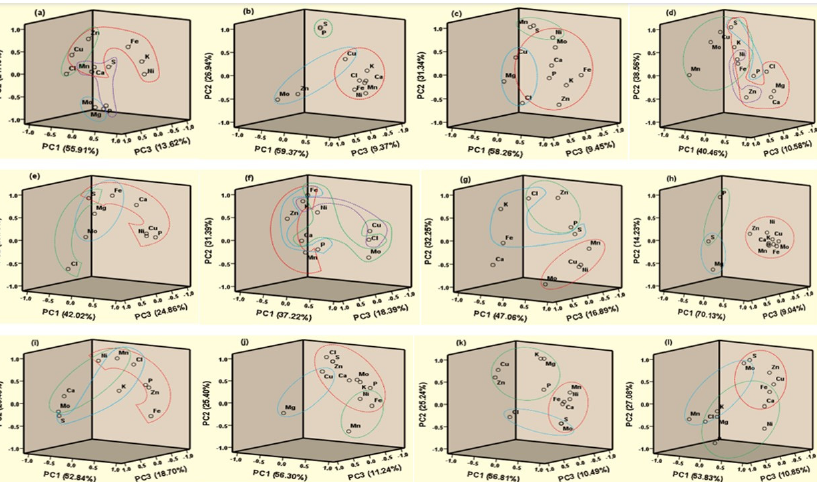
Figure 2. Principal Component (PC) plot of different waste (( a ). brinjal waste, ( b ). potato peels, ( c ). banana peels, ( d ). orange peels, ( e ). eggshell, ( f ). cow bone, ( g ). chicken bone, ( h ). fish bone, ( i ). combined vegetable, ( j ). combined fruit, ( k ). combined animal, and ( l ). all combined).